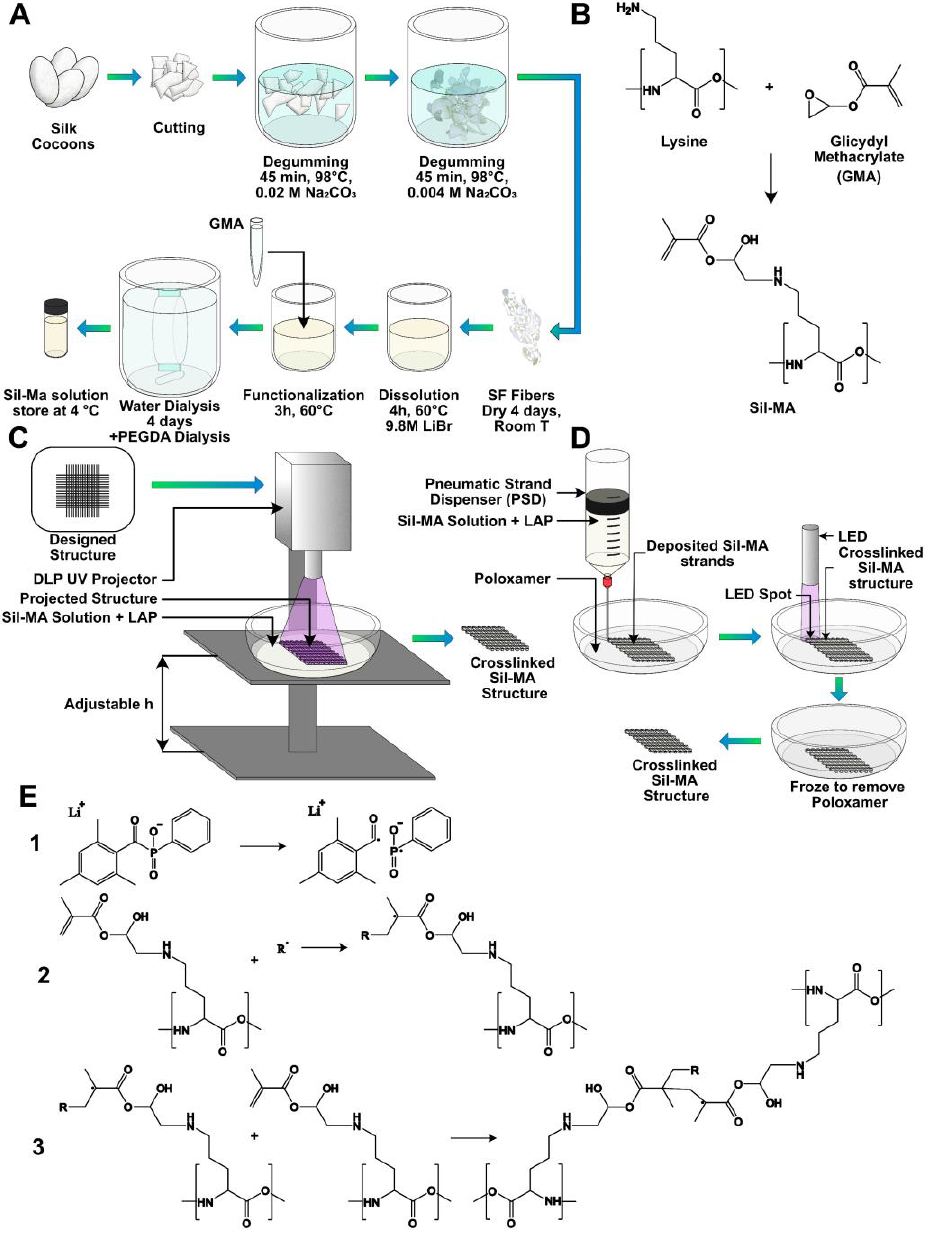
Figure 7. ( A ) Scheme of Sil-MA production starting from Bombyx Mori silk cocoons and ( B ) supposed chemical reaction for the formation of the Sil-MA; a primary amide in the lysine group became a di- β -hydroxyamide, through the nucleophilic substitution of nitrogen on one carbon atom of the epoxy ring of GMA and the consequent ring opening. ( C ) Scheme of the Sil-MA constructs formation through the digital light processing (DPL) projector. ( D ) Scheme of the printing through the use of a pneumatic strand dispenser (PSD) inside a poloxamer support bath, of the crosslinking with LAP and of the removal of the poloxamer by decreasing the temperature below the gel-to-sol transition. ( E ) Scheme of the crosslinking reaction. (1) Formation of radicals under UV light because of the photoinitiator, LAP. (2) Formation of radicals on the protein chain because of the effect of the radicals formed by the photoinitiator (here indicated with R) and the opening of the carbon double bond. (3) Formation of a cross-linking between two chains because of the opening of the carbon double